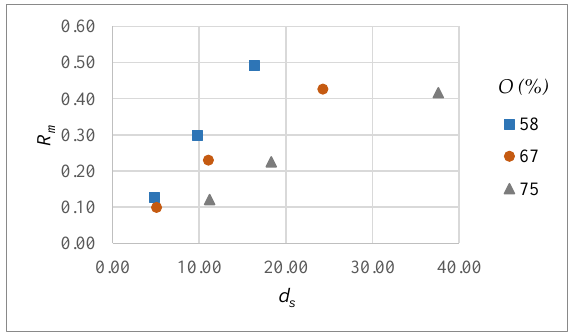
Figure 14. Correlation between d s and 𝑅 𝑚 at different pulse overlaps ( O ).